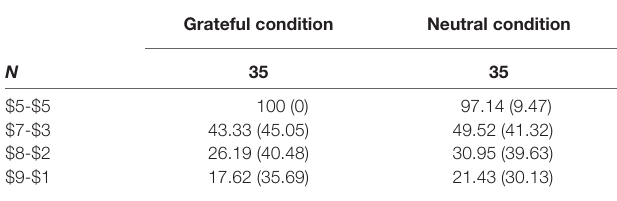
TABLE 1 | Acceptance rates of four offers as a function of the induction conditions. Grateful condition Neutral condition N